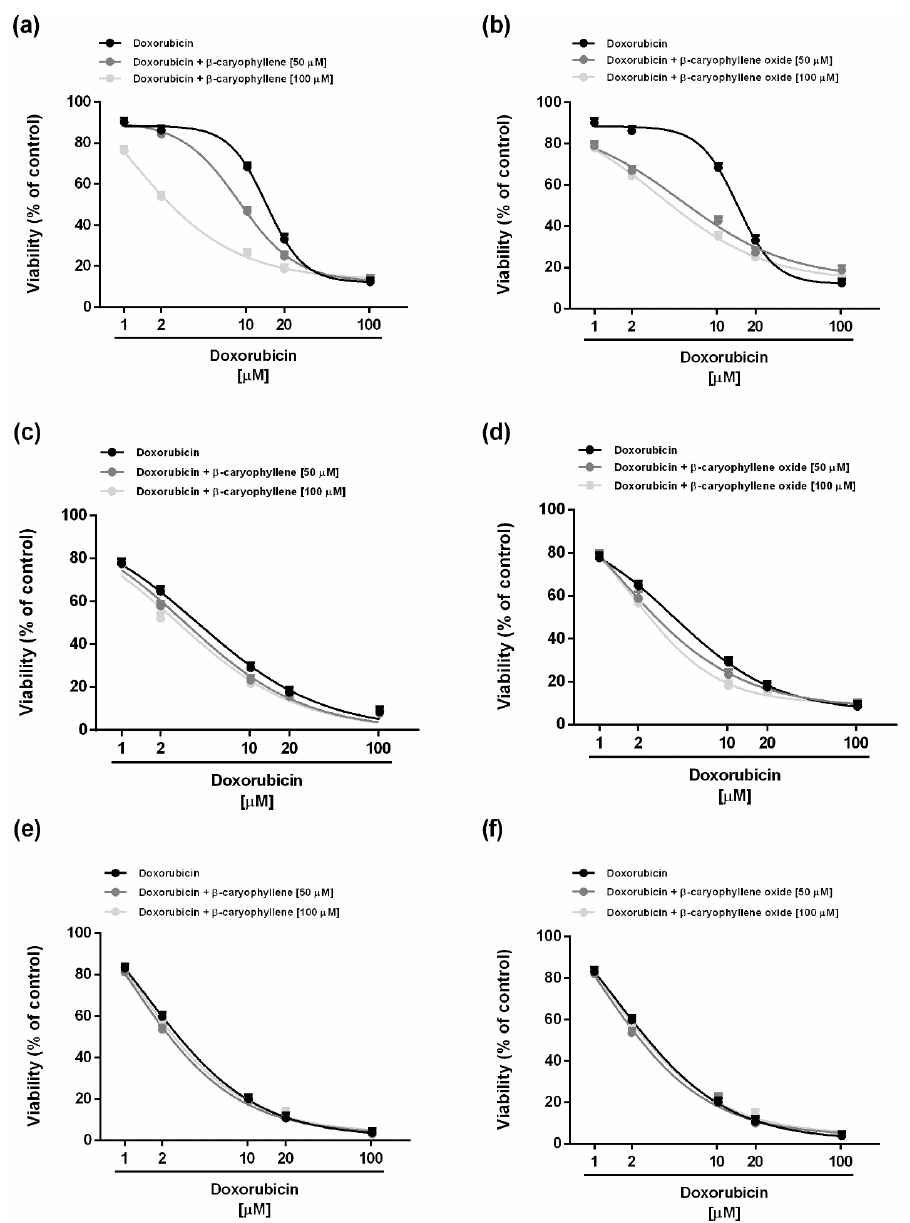
Figure 2. Cytotoxicity of doxorubicin in combination with the sesquiterpenes β - caryophyllene ( a , c , e ) and β - caryophyllene oxide ( b , d , f ) after standard long - term treatments in HepG2 cells. ( a , b ) Single exposure of 24 h. ( c , d ) Single exposure of 48 h. ( e , f ) Single exposure of 72 h. Data represent the mean ± SE (standard error) of at least two experiments in which each treatment was tested in triplicate ( n =